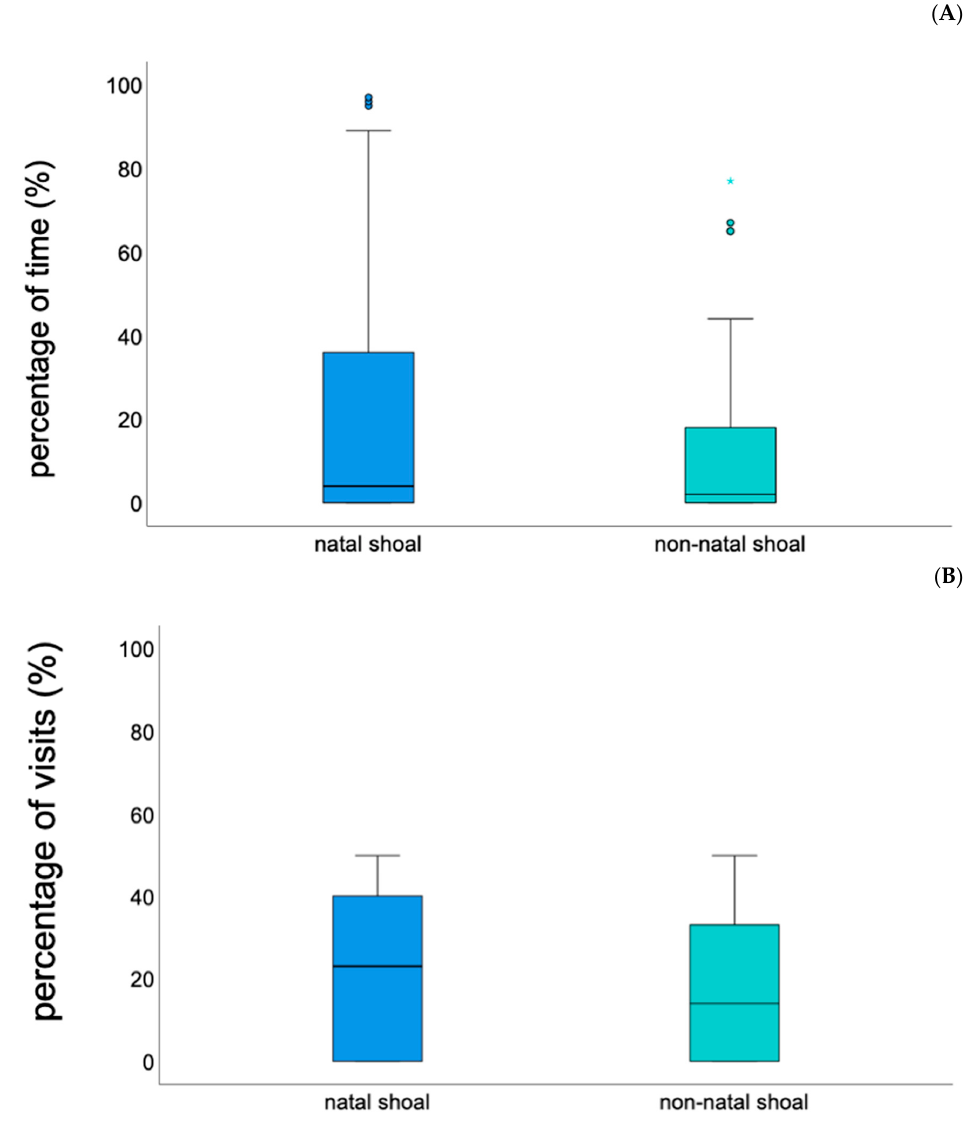
Figure 2. ( A ) Percentage of time (%) spent by the focal fish near the natal and non-natal shoal; ( B ) Percentage of visits (%) performed by the focal fish to the natal and non-natal shoal. The boundaries of the box closest to and farthest from zero indicate the 1st and 3rd quartile, respectively; the black line within the box marks the median; whiskers below and above